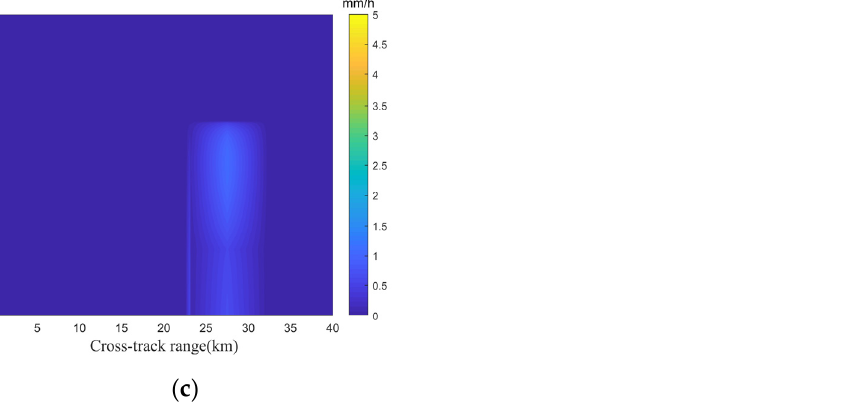
Figure 10. Two-dimensional distribution of triangular rain. ( a ) The given two-dimensional distri- bution of rain; ( b ) the two-dimensional distribution of rain retrieved by MRA; and ( c ) the absolute error diagram.